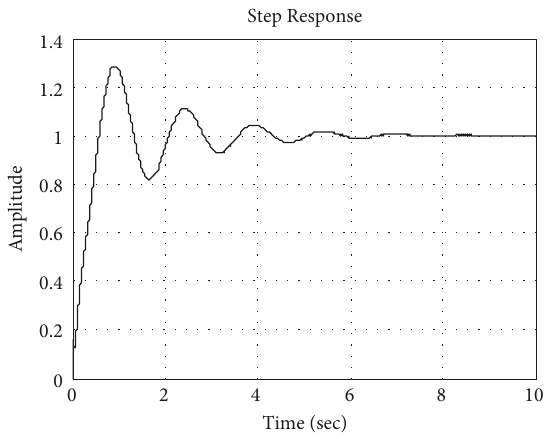
Figure 26: Response curve at 0.1 times β